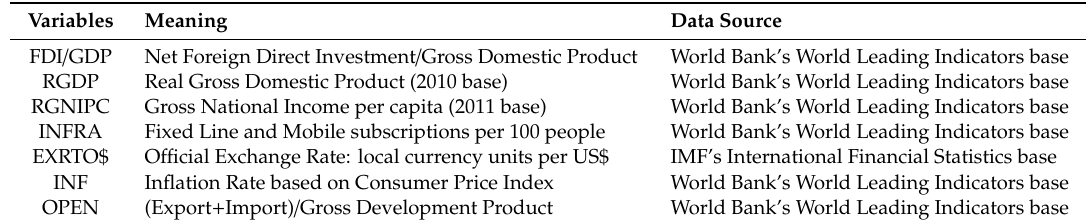
Table 1. Variables in the Models and Data Sources (Created by Authors) (World Bank n.d.) (IMF n.d.).